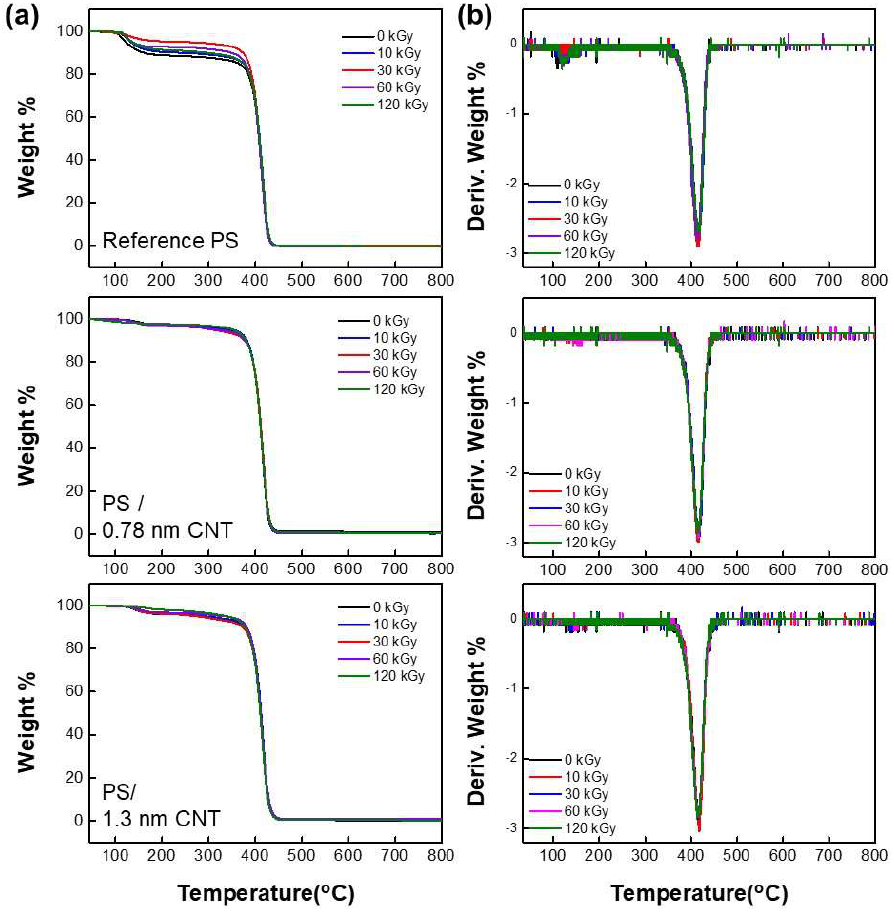
Figure 2. TGA ( a ) and DTG ( b ) profiles of PS and PS/SW-CNTs with diameters of 0.78 and 1.3 nm under various gamma-radiation conditions.